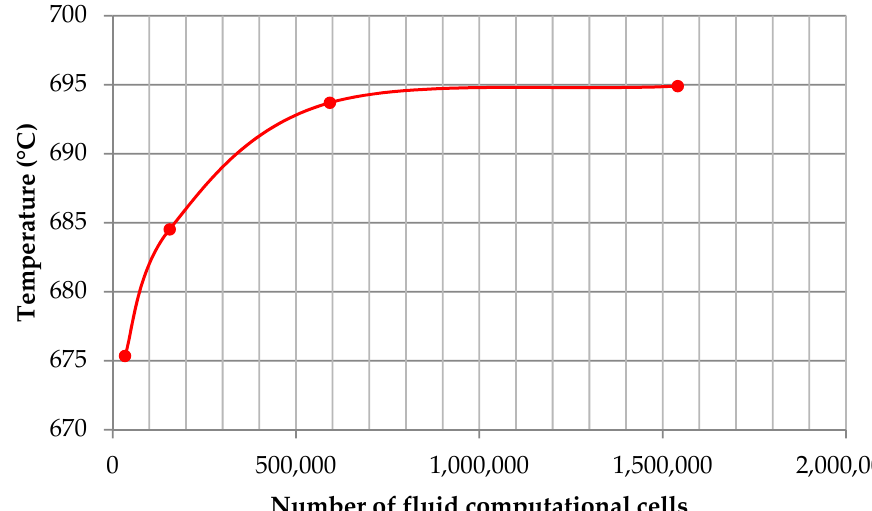
Figure 21. Convergence of results in numerical grid refinement study. The results of the four mesh densities were compared in Table 3. Table 3. Results of numerical grid refinement study.